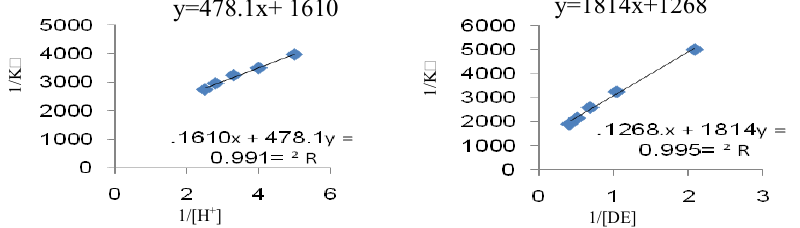
Figure 1 . plot of 1/k o versus 1/[H + ]and 1/[DE]; [CAT]=0.001 M; μ=0.25 M; Temperature=313K o